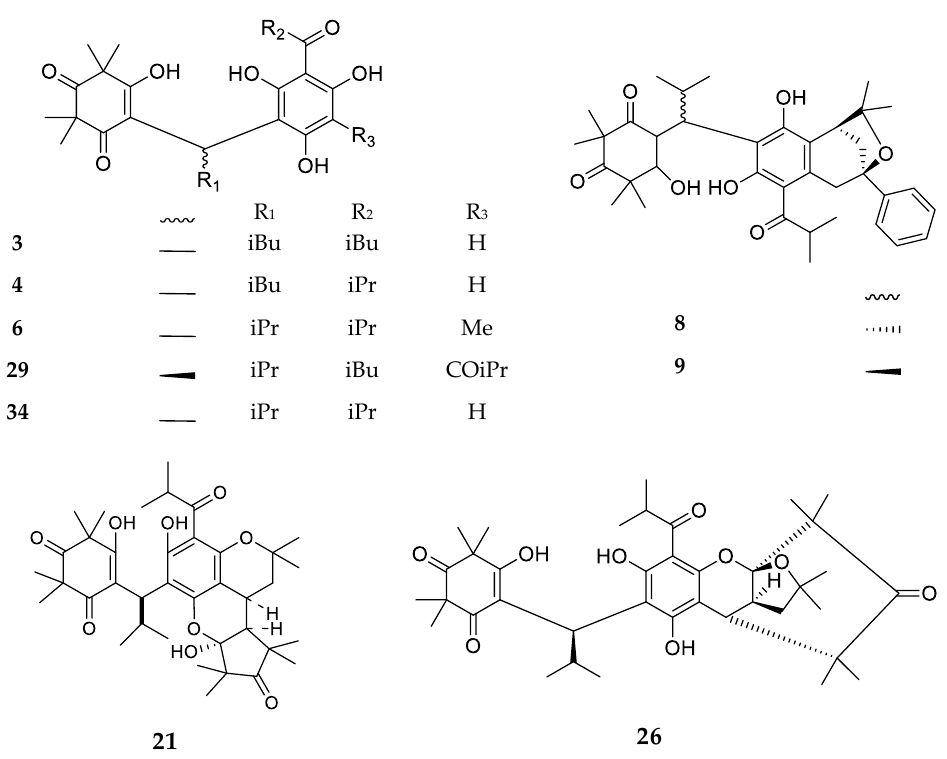
Figure 1. Structures of compounds of the dimeric type.